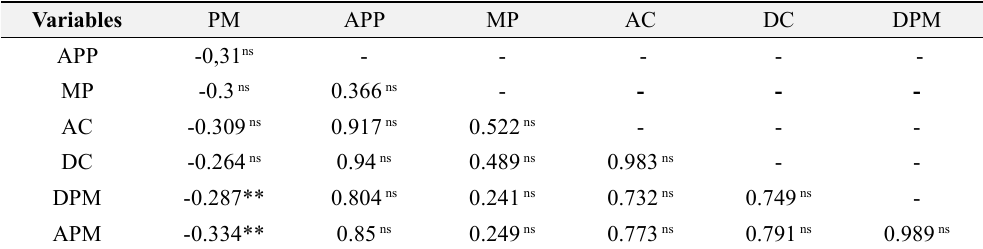
Table 2 - Correlation of production and biometric variables of colonies of four species of stingless bees in the municipalities of Palmas-TO, Brazil.